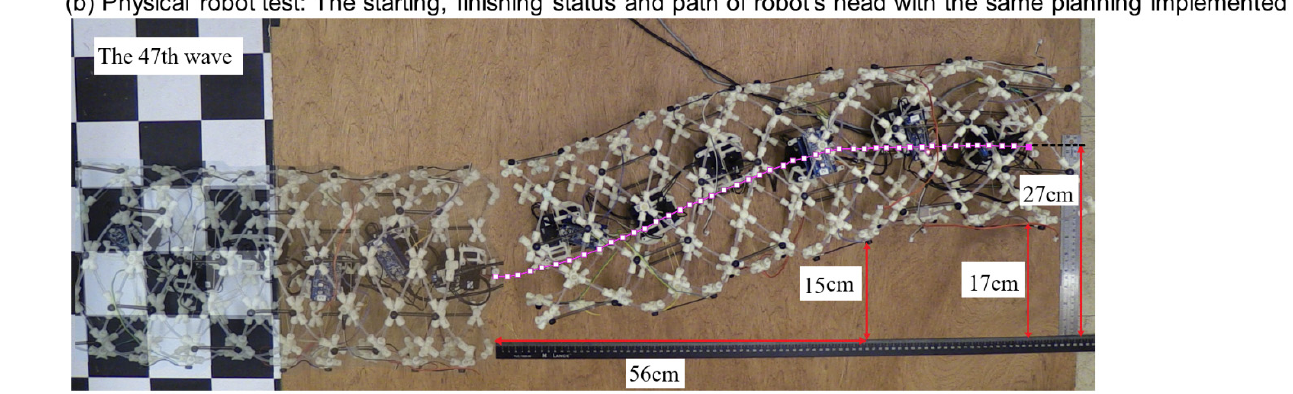
Figure 14. ( a ) simulated robot and obstacle avoidance path. The total displacement is 70 cm on the x-axis and 20 cm on the y-axis ( b ) The starting and finishing status of the physical robot with the same path implemented.